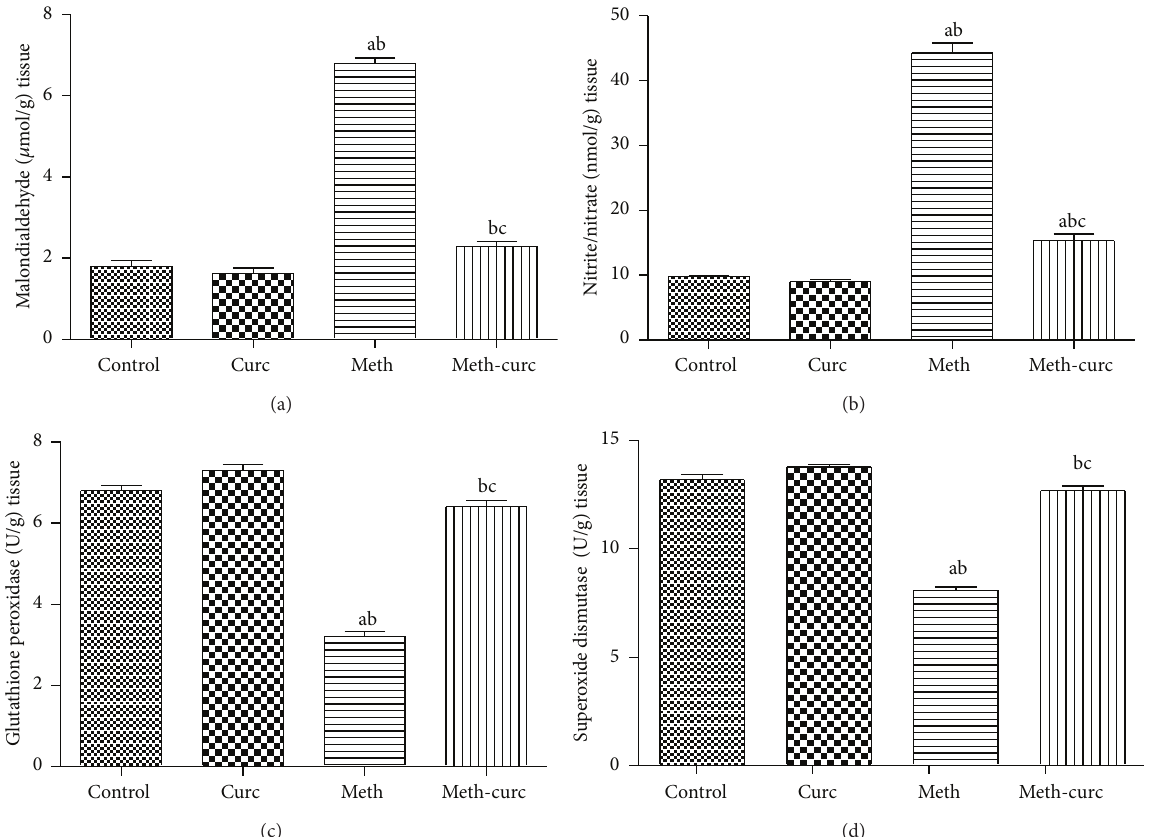
Figure 3: Effect of curcumin (Curc) on renal malondialdehyde (a), nitric oxide (as nitrite/nitrate; (b)), glutathione peroxidase (c), and superoxide dismutase (d) levels of methotrexate- (Meth-) induced nephrotoxicity in rats. Data are mean ± SEM of 6–8 rats. a , b , c Significantly different from control, Curc, and Meth groups, respectively, at 𝑃 < 0.05 .